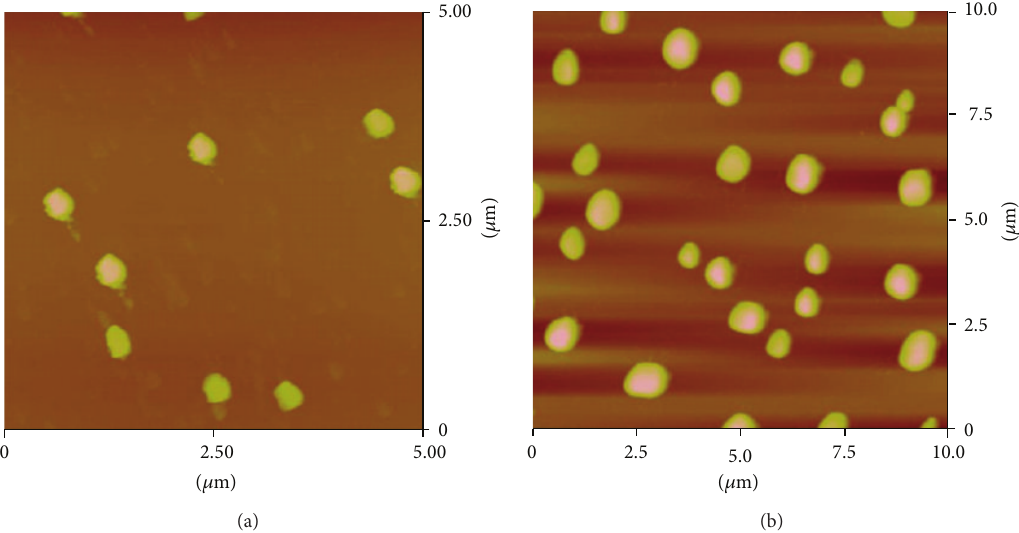
Figure 3: AFM image of DPG prepared using different initial polymer mass concentrations. (The scanned area in Figures 3(a) or 3(b) is 5 ×